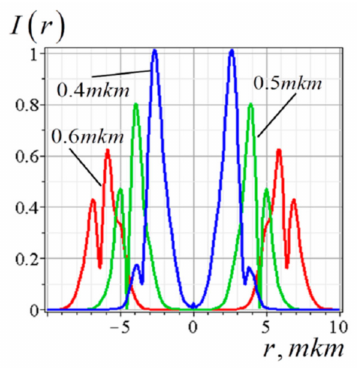
Figure 13. Beam intensity profile with K o = i 3 · 10 3 , w 0 = 10 mkm, z = 0.21 mm, λ s = 0.6